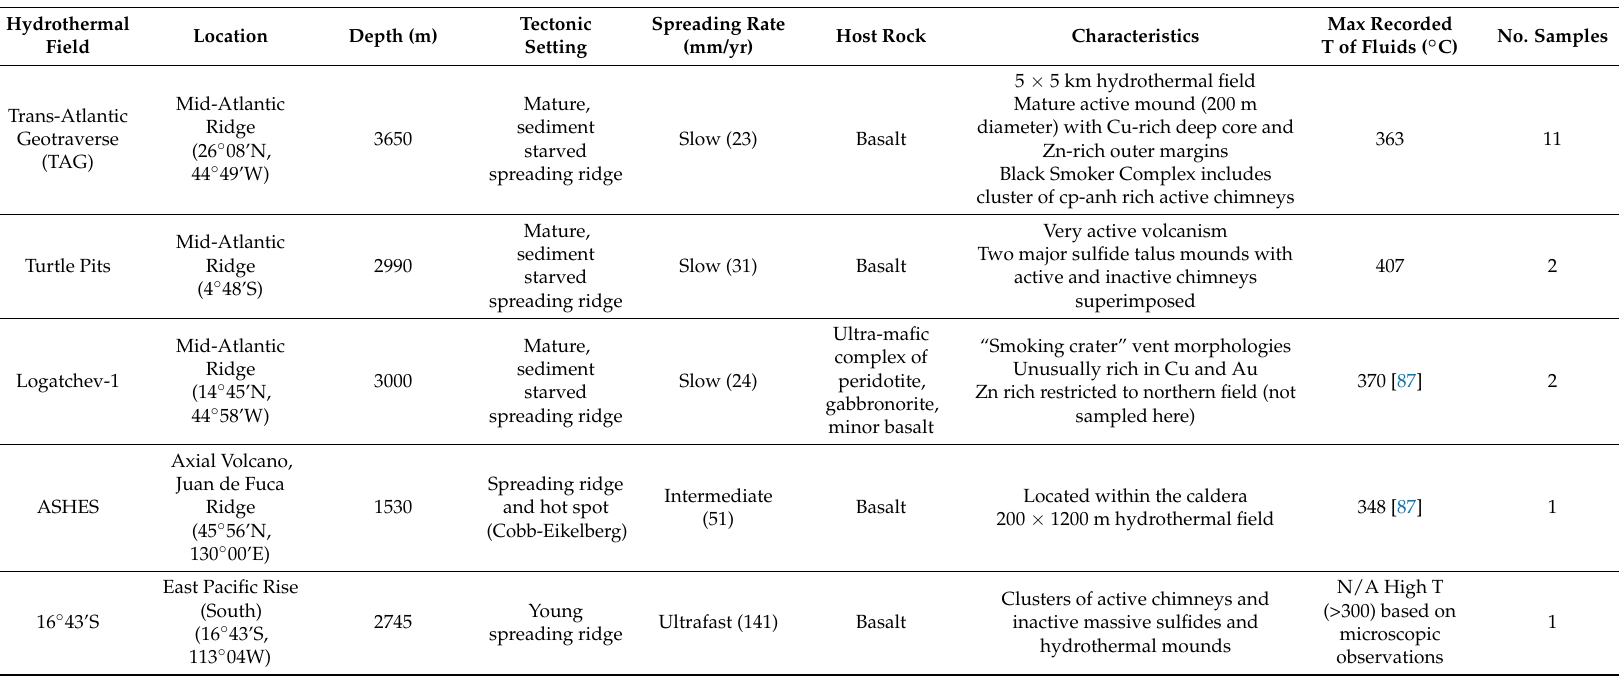
Table 1. Location and features of the hydrothermal fields and their geological settings of the samples analysed in this study. Hydrothermal